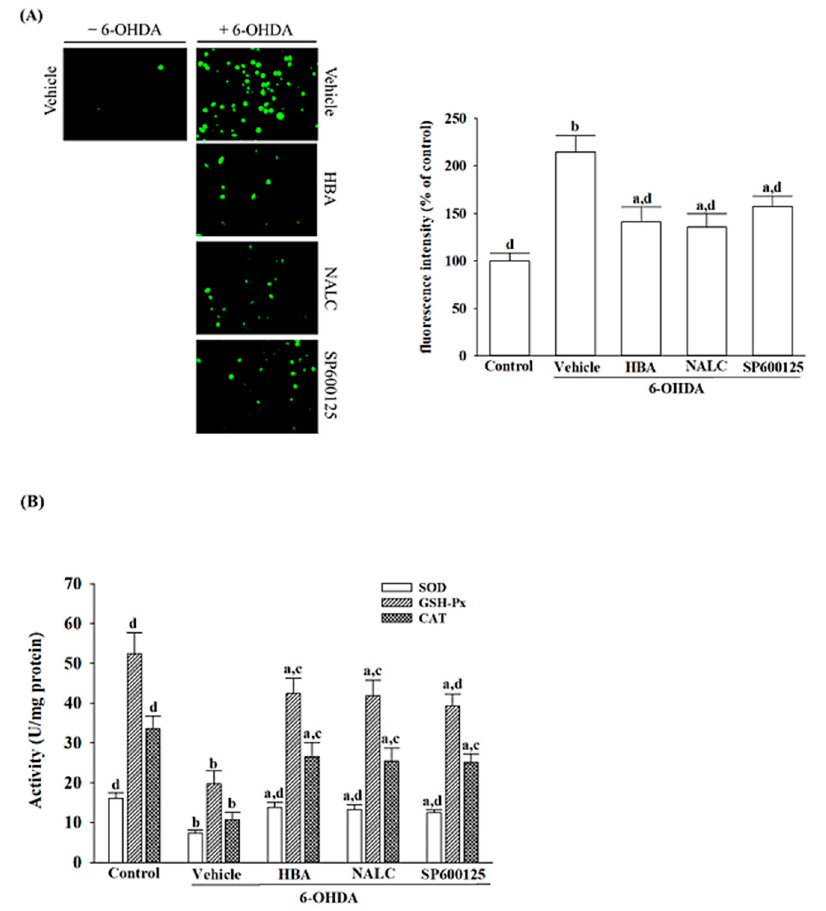
Figure 2. HBA reduces SH-SY5Y from the oxidative stress induced by 6-OHDA. SH-SY5Y cells were pretreated with HBA (120 µ mol/L), NALC (1 mmol/L), or SP600125 (10 µ mol/L) for 1 h and then exposed to 6-OHDA (100 µ mol/L) for another 24 h. ( A ) Fluorescence images representative of intracellular ROS production were detected using DCFH-DA fluorescent probes (200 × g magnification). The ROS fluorescence intensity is represented as a percentage in comparison with untreated control cells. ( B ) The activities of SOD, GSH-Px, and CAT were identified using commercial analysis packages. The results are shown as the mean ± SD of five independent experiments ( n = 5) performed in triplicate. a p < 0.05 and b p < 0.01 compared to the data from untreated control group (control); c p < 0.05 and d p < 0.01 compared to the data from cells exposed to 6-OHDA with no treatment.